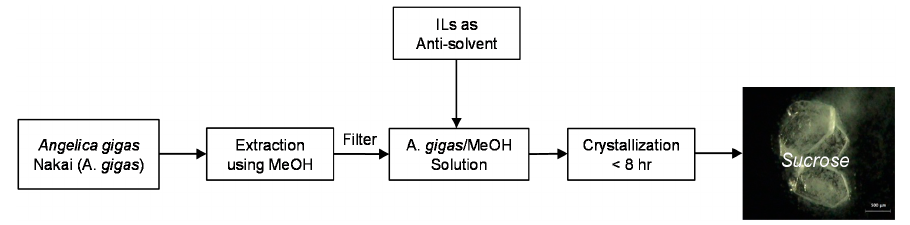
Figure 1. The selective crystallization separation procedure diagram for the isolation of sucrose form the methanol extract of A. gigas using Ionic liquids.